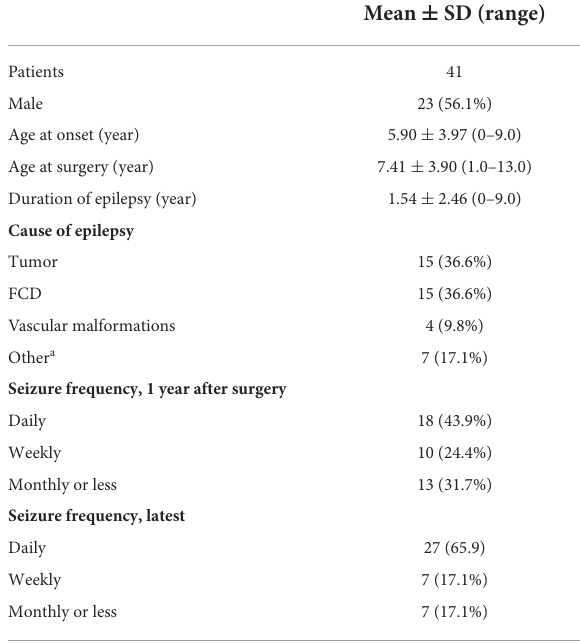
TABLE 1 Characteristics of children with residual seizure after epileptic resection